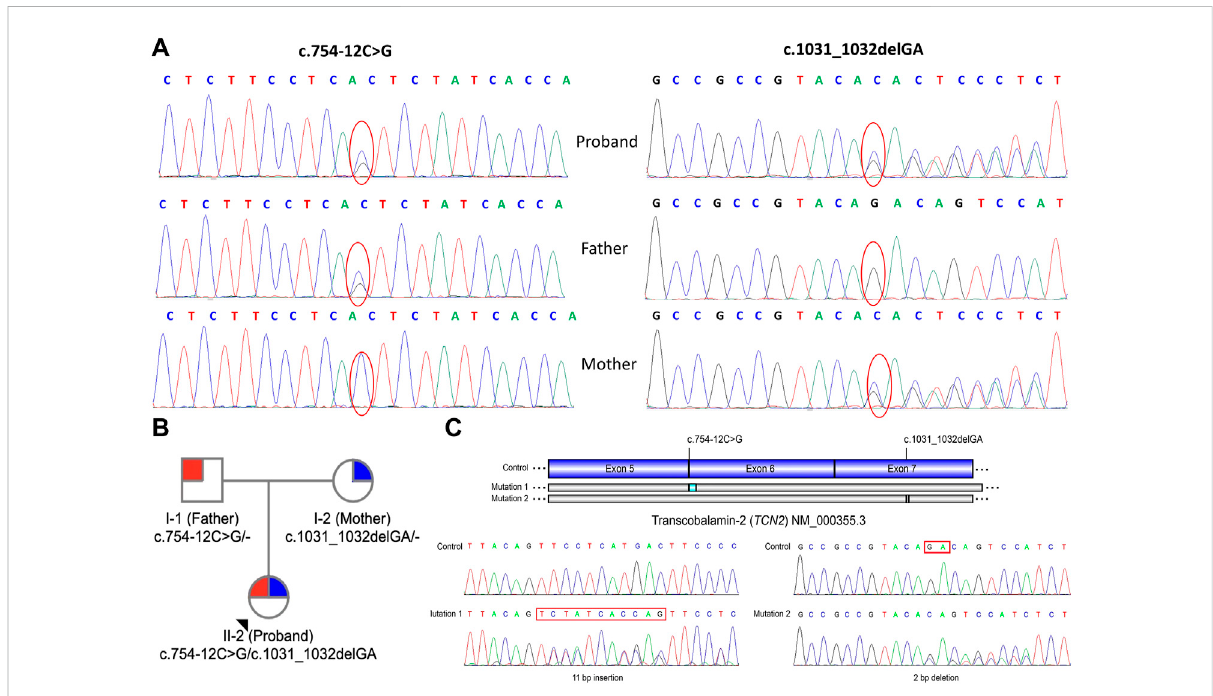
FIGURE 1 Genetic information of the patient. (A) Sanger sequencing showed a heterozygous maternally inherited variants (c.1031_1032delGA) and a heterozygous paternally inherited variant (c.754 – 12C > G) in TCN2 gene in patient. (B) Pedigree analysis of this family. (C) Reverse transcription and